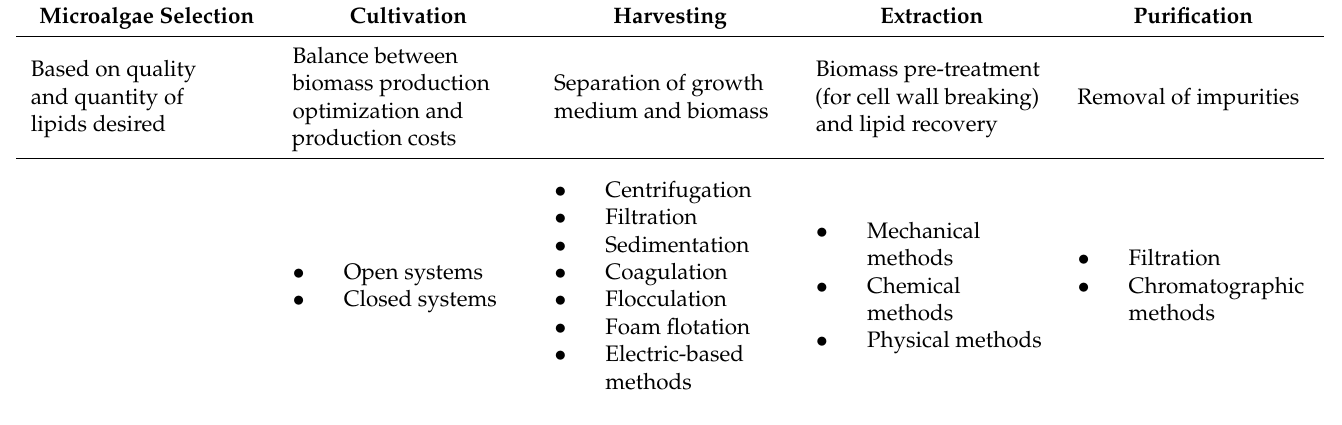
Table 2. Microalgae cultivation process and aims of each